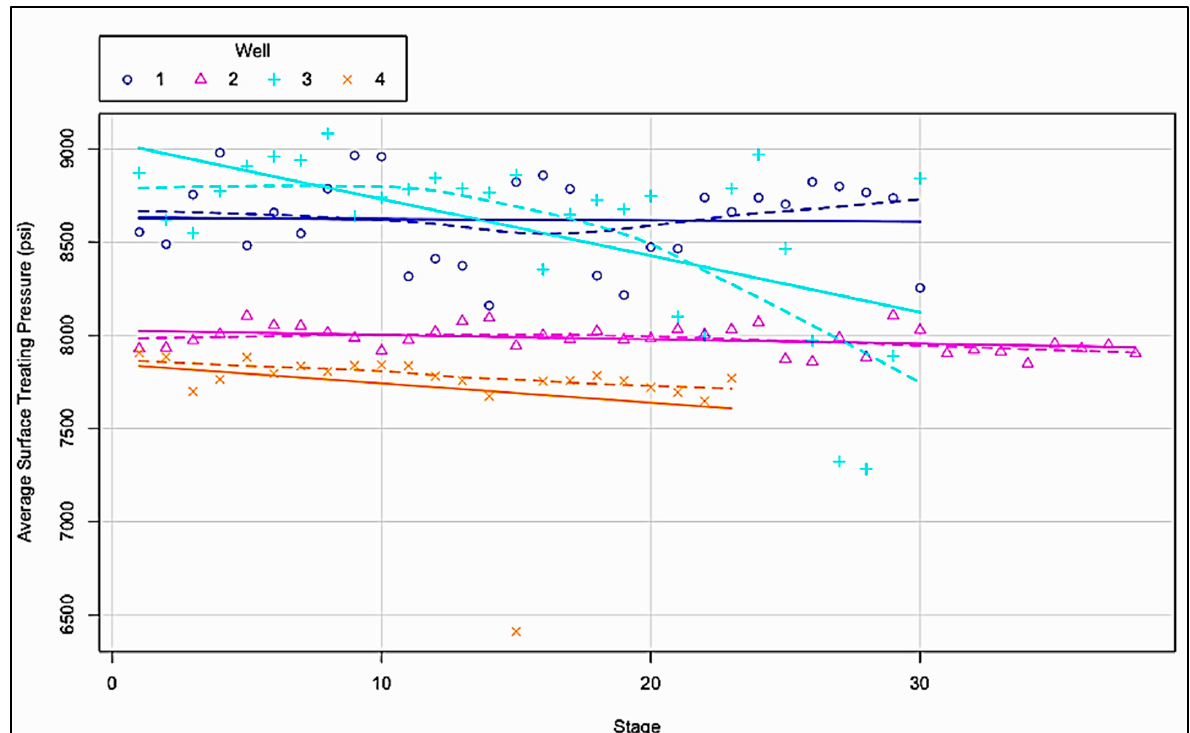
Figure 2. Location map [20].